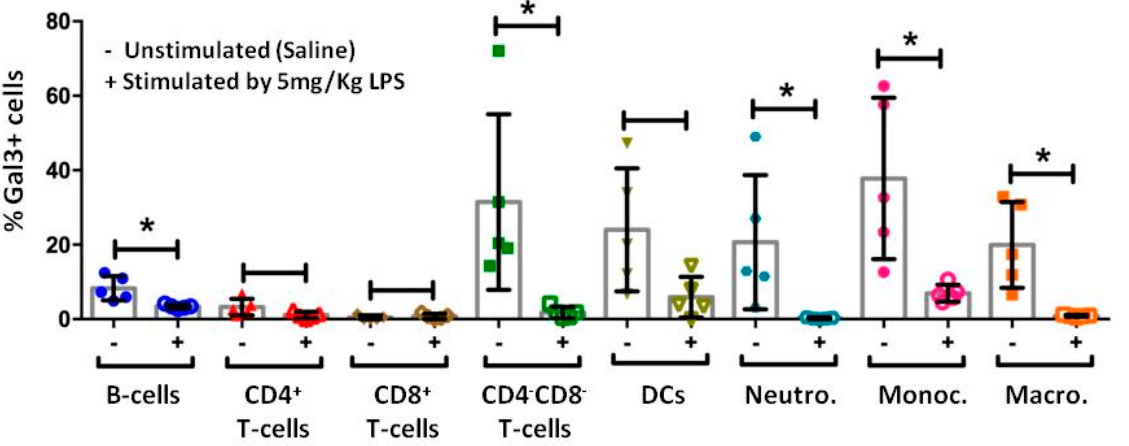
Figure 2. Determination of Gal3 on immune cells of peripheral blood. Levels of Gal3 were determined by flow cytometry in peripheral blood of mice ( N = 5 animals). Briefly, after blood collection, erythrocytes were lysed using an ammonium chloride lysis solution. Cells were washed and stained with surface marker antibodies for 20 min on ice. Gal-3 expression was analyzed in B-cells, CD4 + T-cells, CD8 + T-cells, double negative T-cells, dendritic cells, neutrophils, and macrophages. Results are expressed as median ± IQR. Statistical significance was calculated using the Mann–Whitney U test. Abbreviations: DCs, dendritic cells; Macro, macrophages; Monoc, monocytes; Neu- tro, neutrophils. *, p < 0.01.